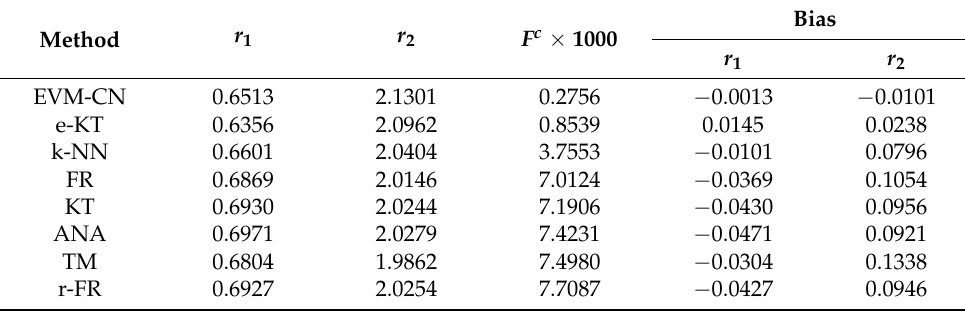
Table 17. Reactivity ratios obtained in the imposed conditions of